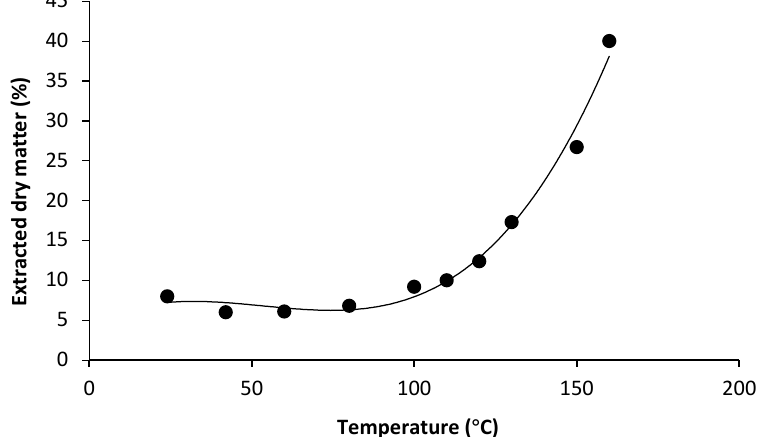
Figure 5. Extracted dry matter as a function of the extraction temperature, obtained after 2 h of hydrothermal extraction at laboratory-scale.